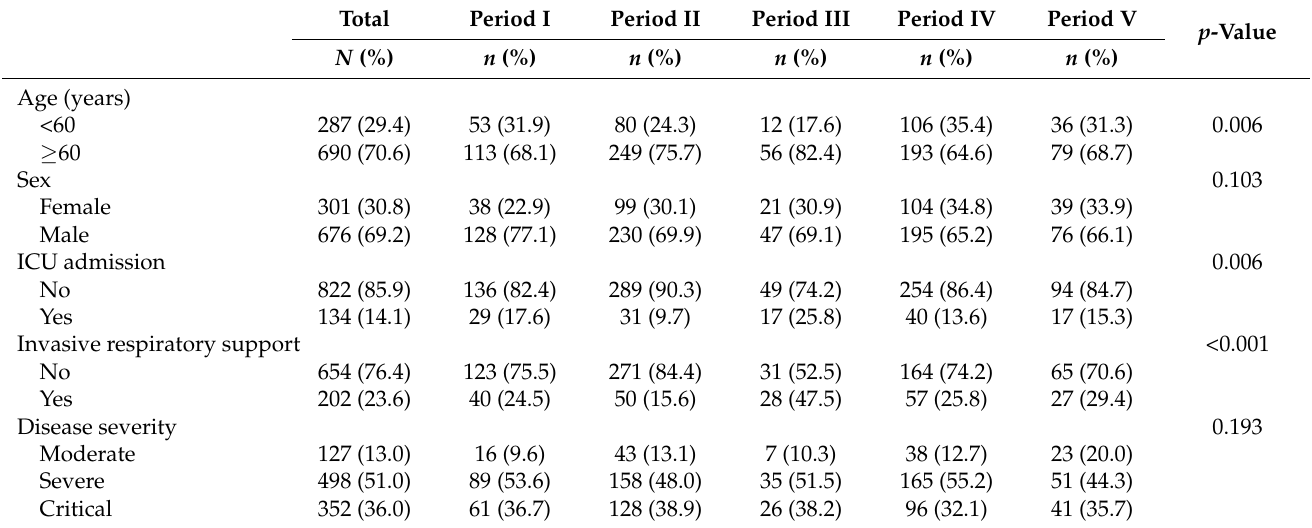
Table 2. Characteristics of subjects who died from COVID-19 in Cusco,